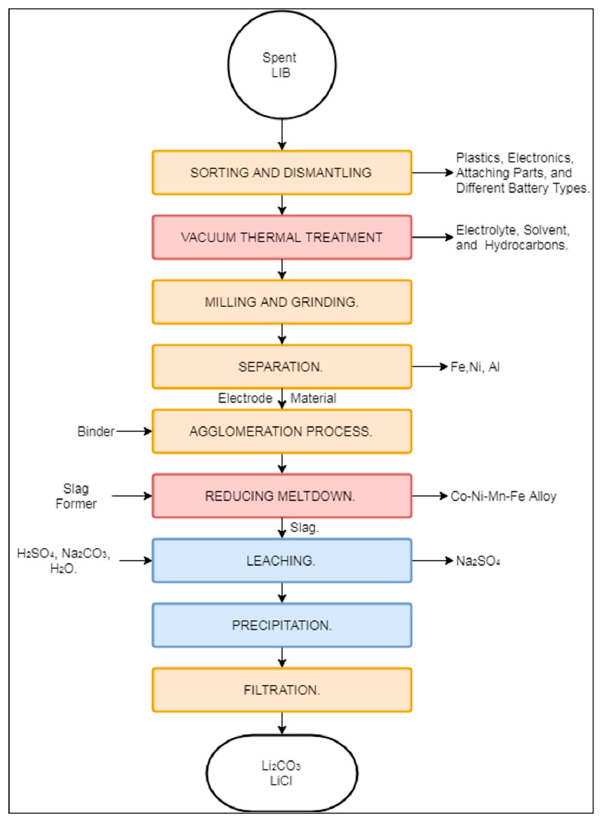
Figure 7. Schematic representation of the Accurec process.